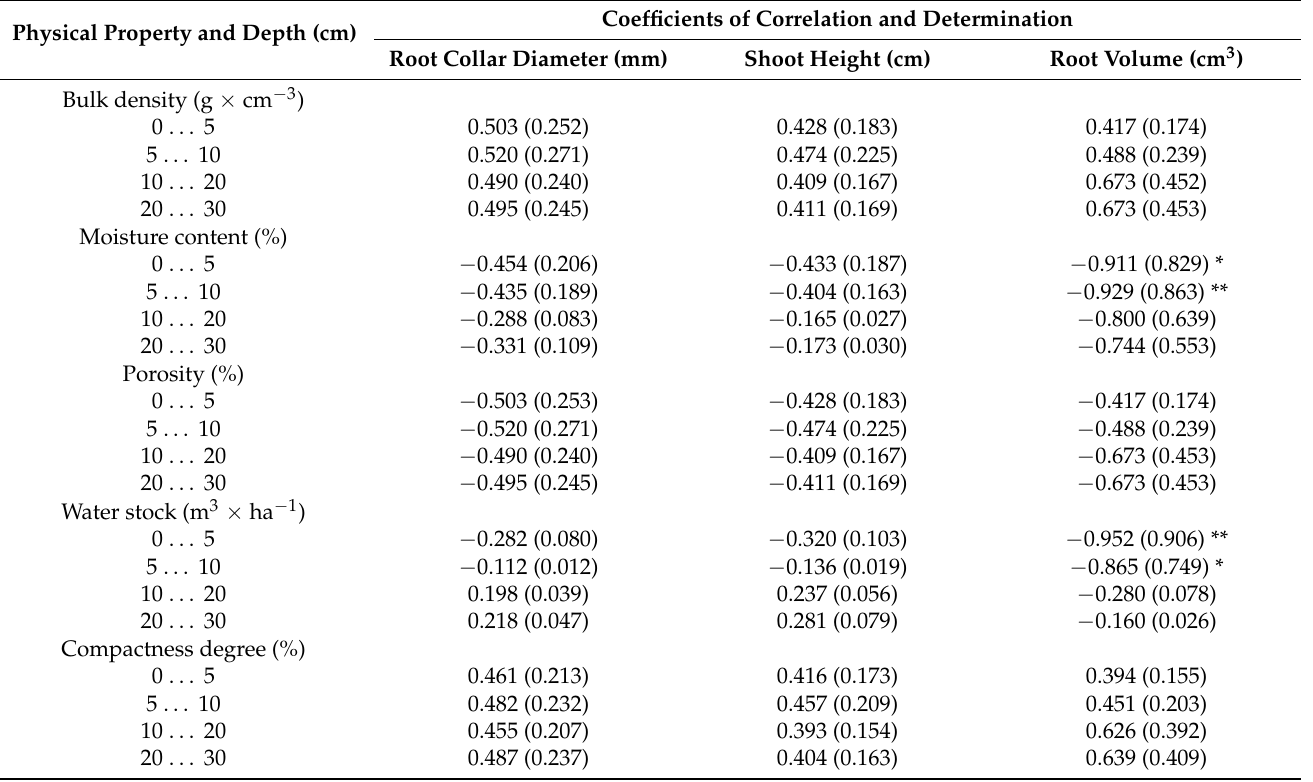
Table 6. Statistics of Correlation and Dependence of Seedling Growth Parameters on the Soil Physical